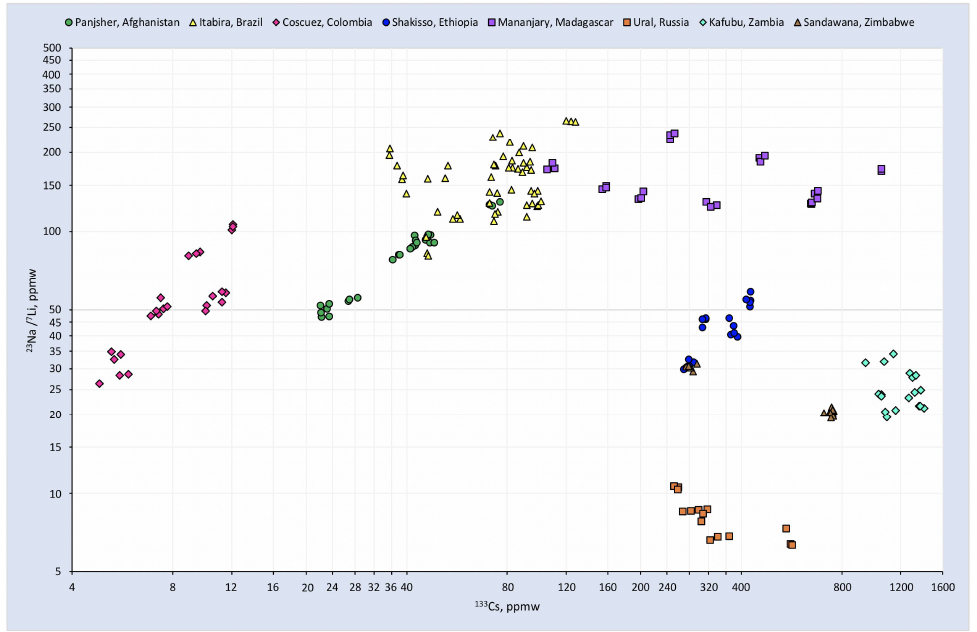
Figure 11. Binary plot of ratios 133 Cs vs. 23 Na / 7 Li.